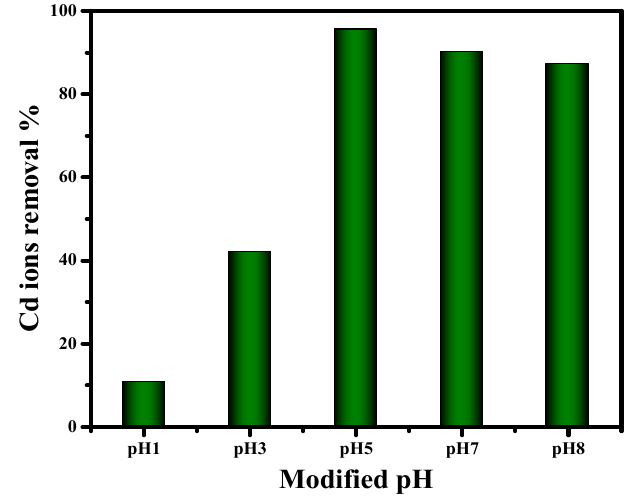
Figure 7. Effect of disparity pH on Cd (II) adsorption.